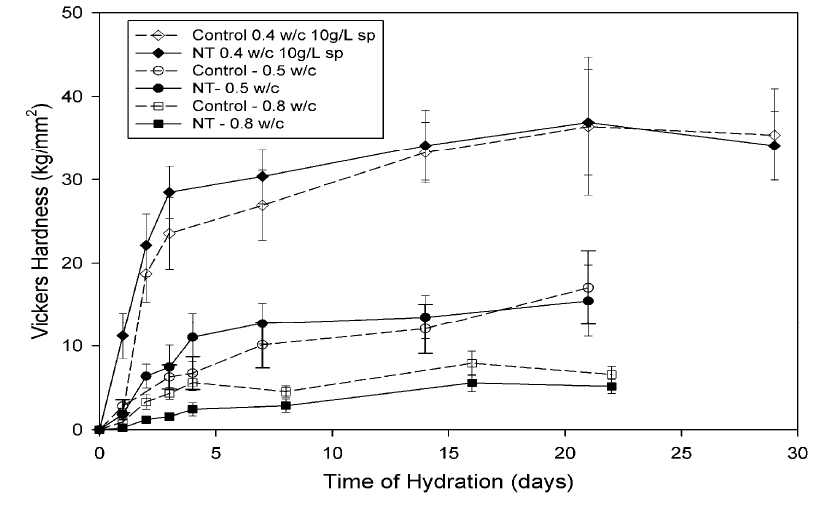
Figure 8. Hardness measurements on cement compacts made at different water/cement